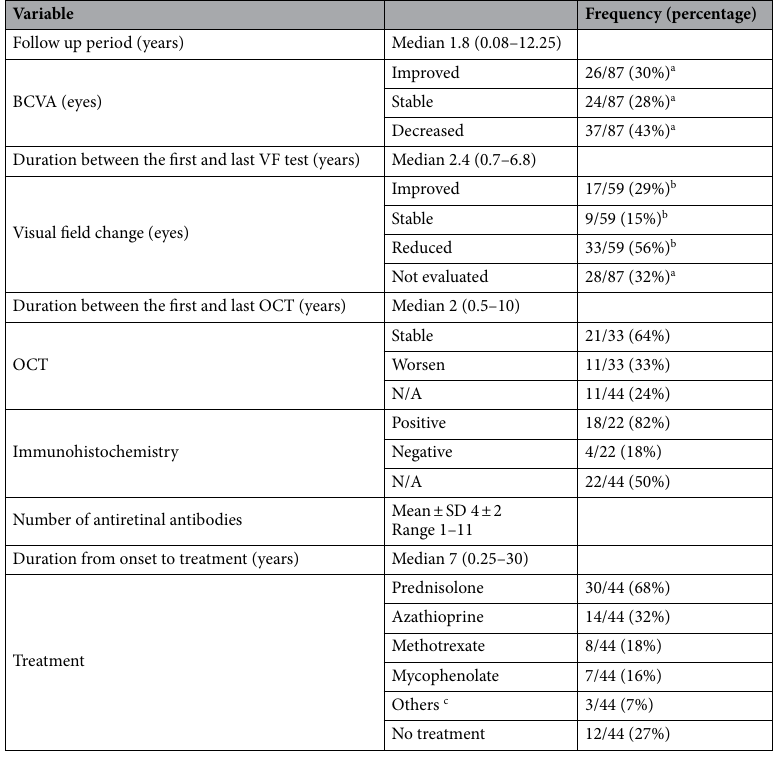
Table 2. Summary of patient follow up. BCVA best corrected visual acuity, OCT optical coherence tomography, VF visual field, N/A not applicable. a One patient had a prosthetic eye. b VF was compared to the baseline. c Cyclosporine, leflunamide, dexamethasone, intravenous immunoglobulins (IVIG),